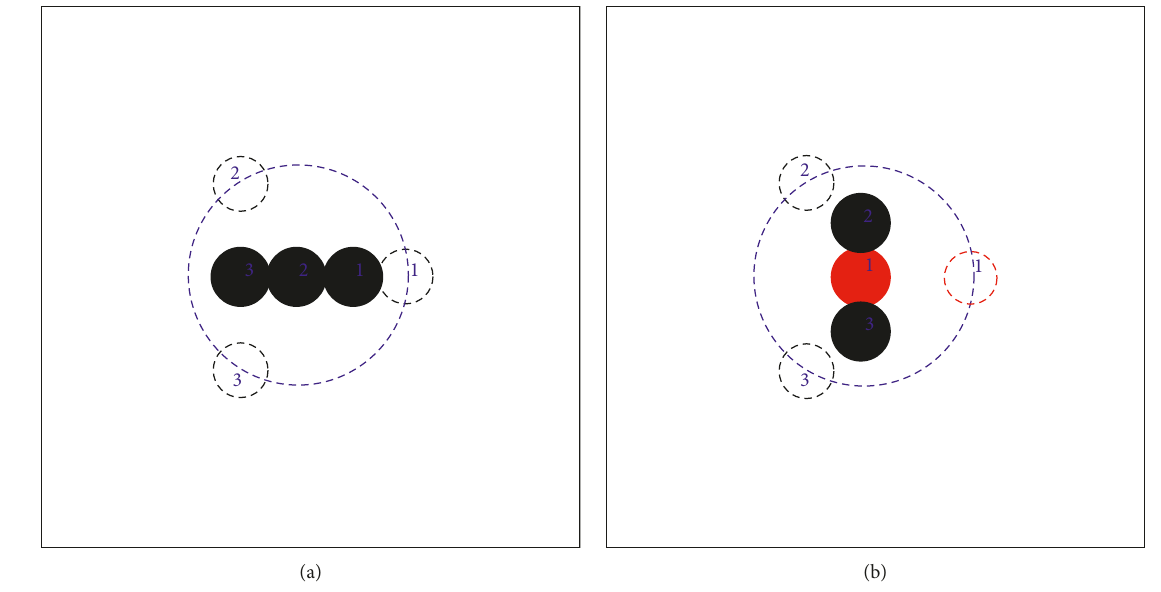
Figure 6: The initial position of three particles is initially equispaced on a circle with θ along x direction, and the final particle chains after DEP interaction under different status: (a) three negative DEP particle and (b) two negative and one positive DEP particle.